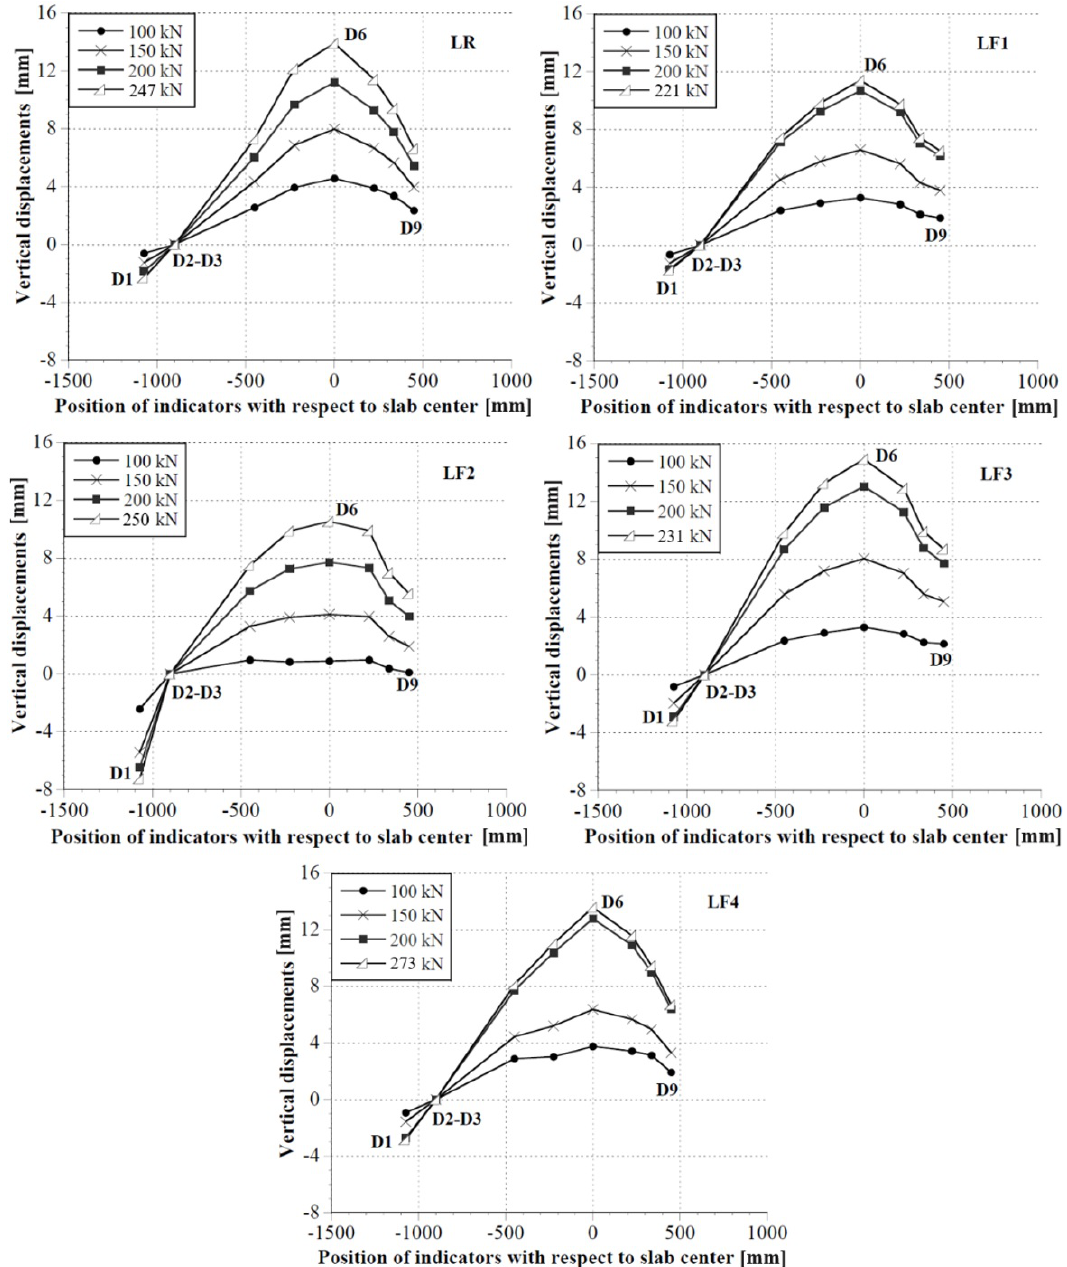
Figure 10. Vertical displacements vs position of indicators in the